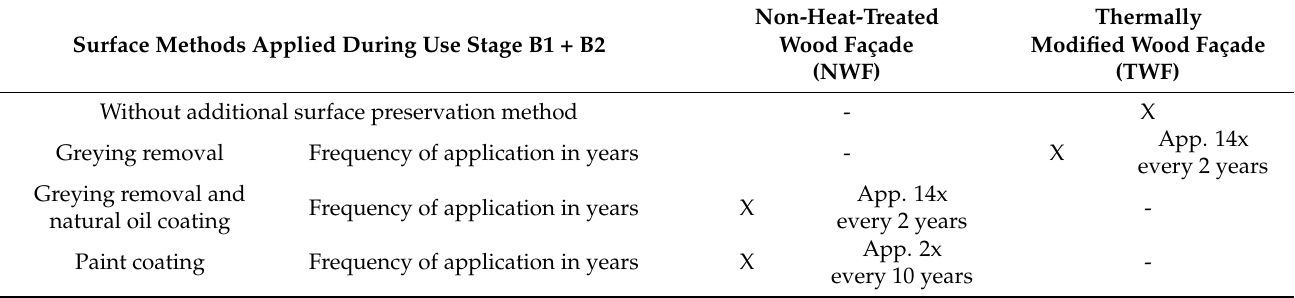
Table 1. Surface coatings for façades applied on thermally modified (TWF) and non-heat-treated wood (NWF)—frequency of use for use stage B1–B2.